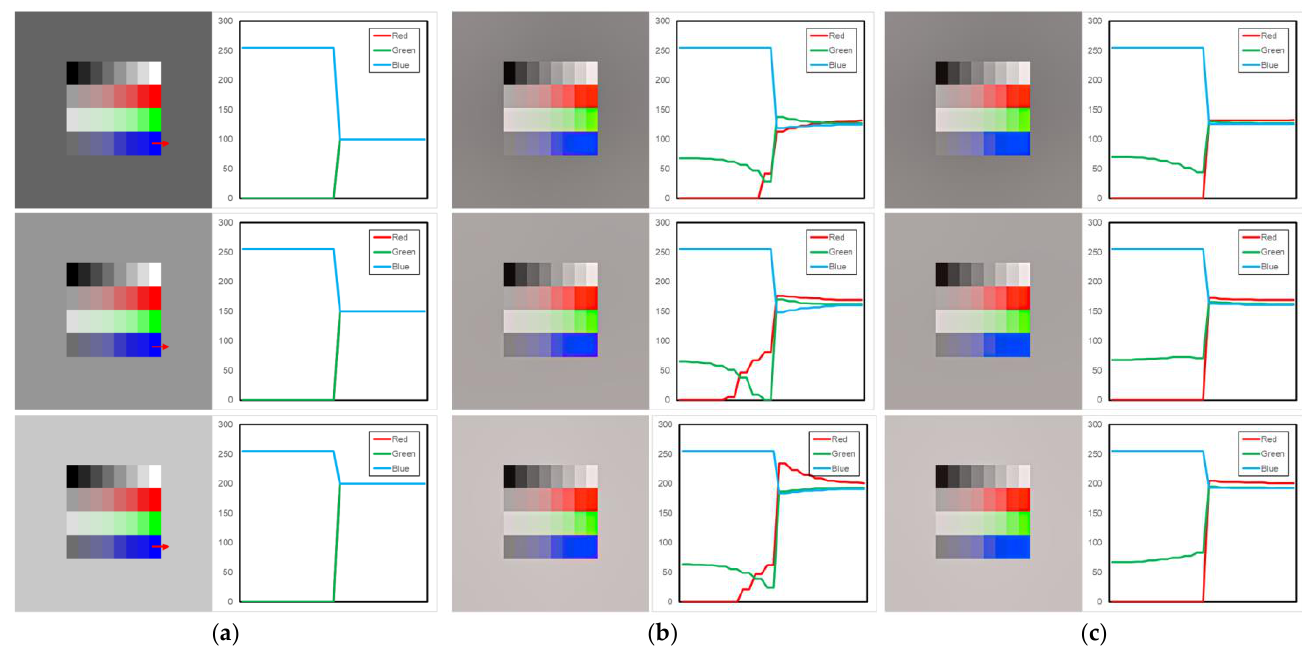
Figure 7. Rendering result of each method for test pattern #2; ( a ) input images; ( b ) iCAM06; ( c ) proposed method. The intensity level of gray surround is 100, 150, and 200 from the first row. Red arrows in ( a ) indicate the scan line for the RGB pixel distribution graph on the right side.